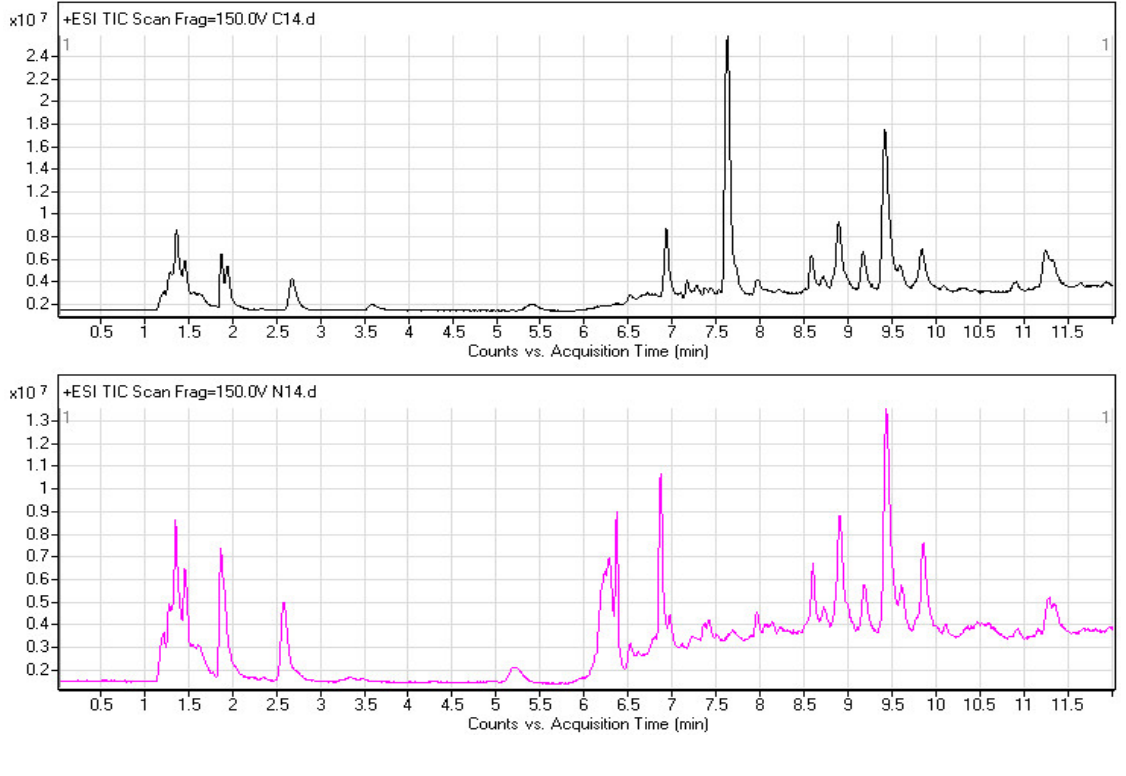
Figure 1. TICs of human plasma samples from an ESCC patient (upper black) and matched healthy control (lower red) in positive ionization mode by using UPLC-ESI-TOF/MS